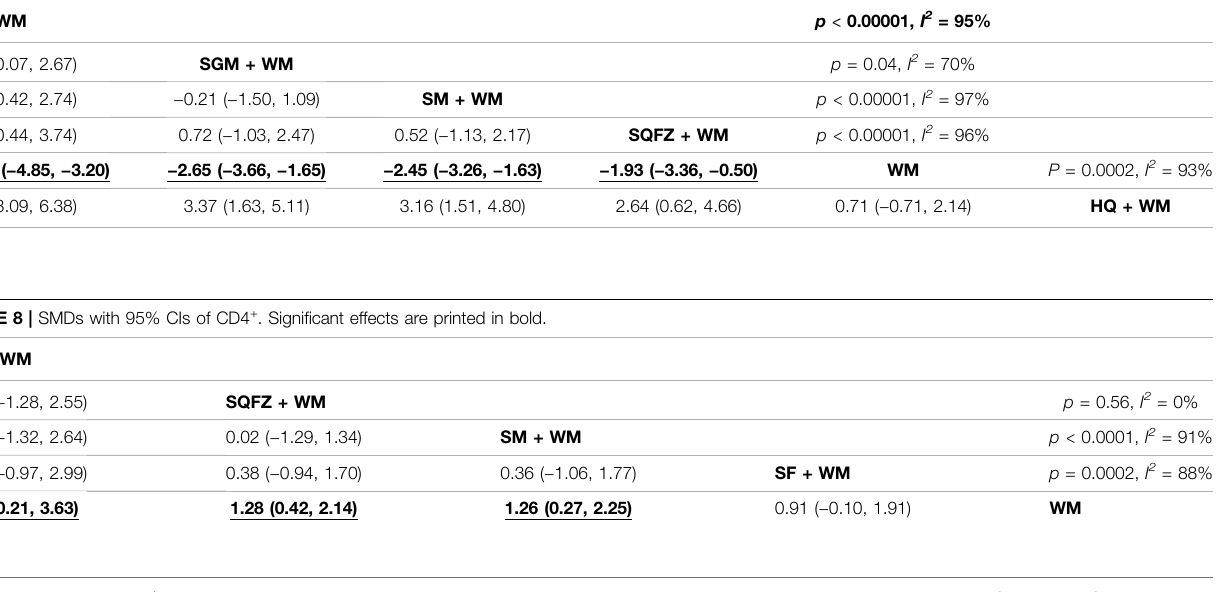
TABLE 7 | SMDs with 95% CIs of TNF- α . Signi fi cant effects are printed in bold.